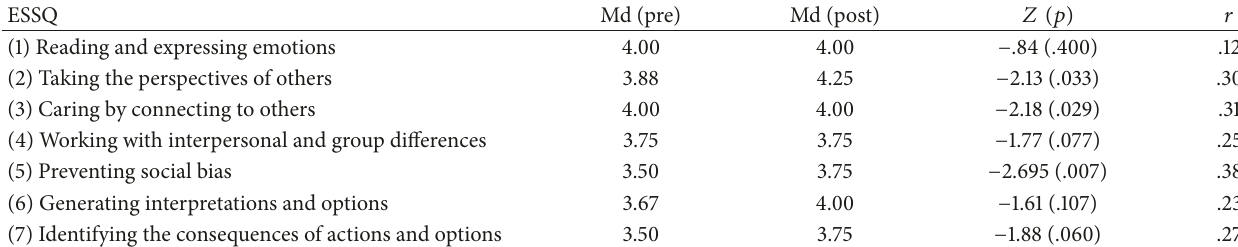
Table 6: Pre- and posttest differences on ethical sensitivity (ESSQ). 𝑁 = 25 .